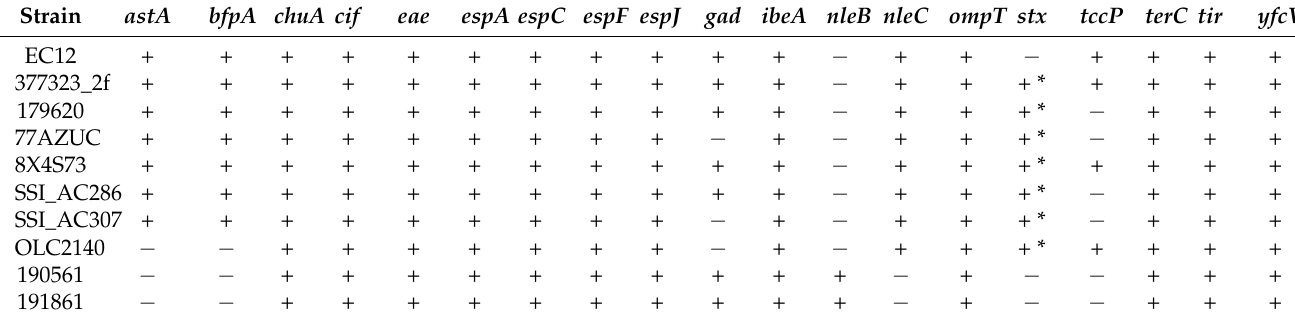
Table 1. Distribution of virulence genes identified in the genomes of E . coli O63:H6 strains. Strain